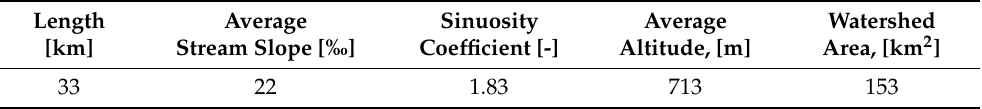
Table 3. The morphometric characteristics.